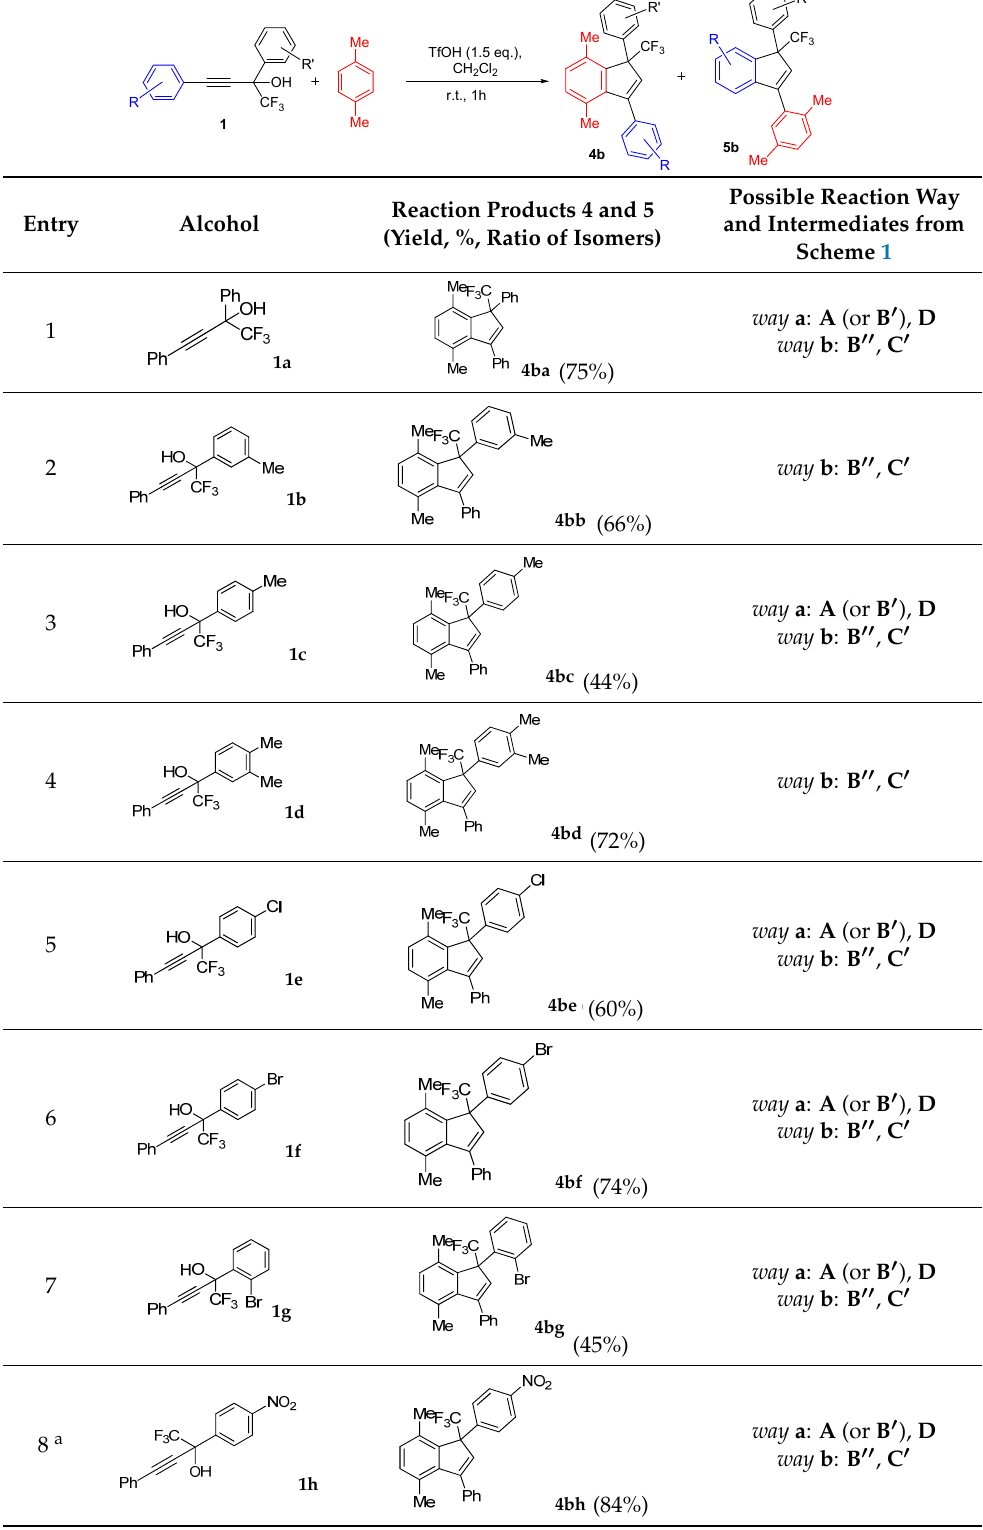
Reaction Products 4 and 5 (Yield, %, Ratio of